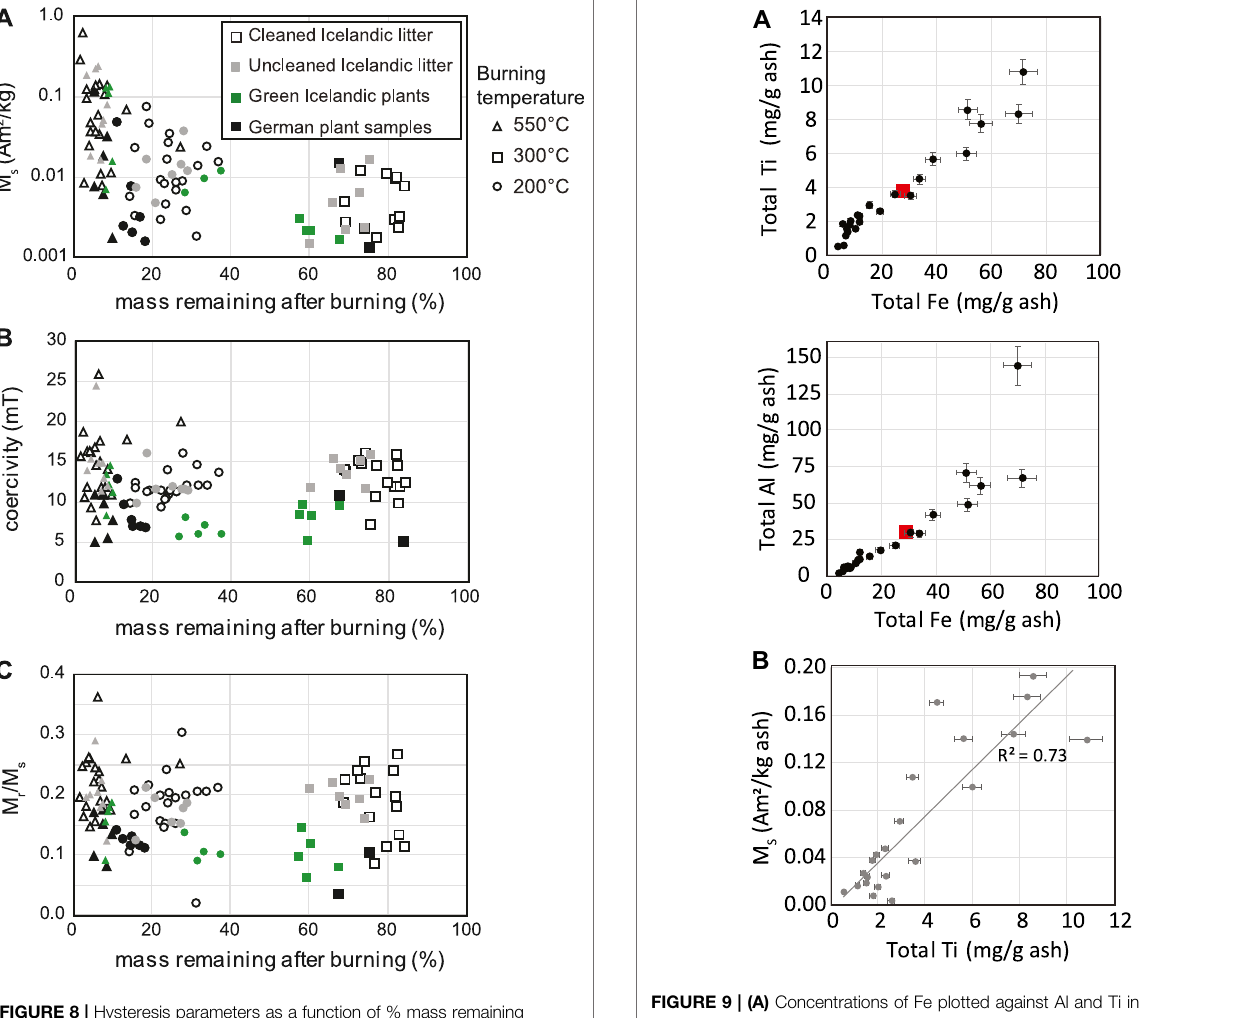
Frontiers in Earth Science |